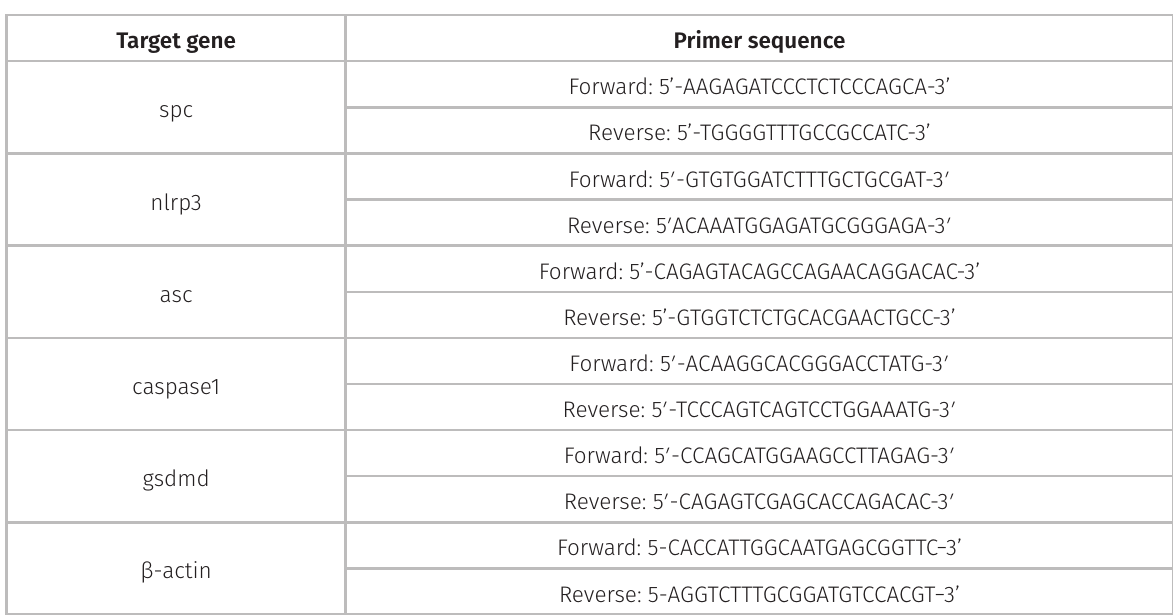
Table I .Primer sequences of the target